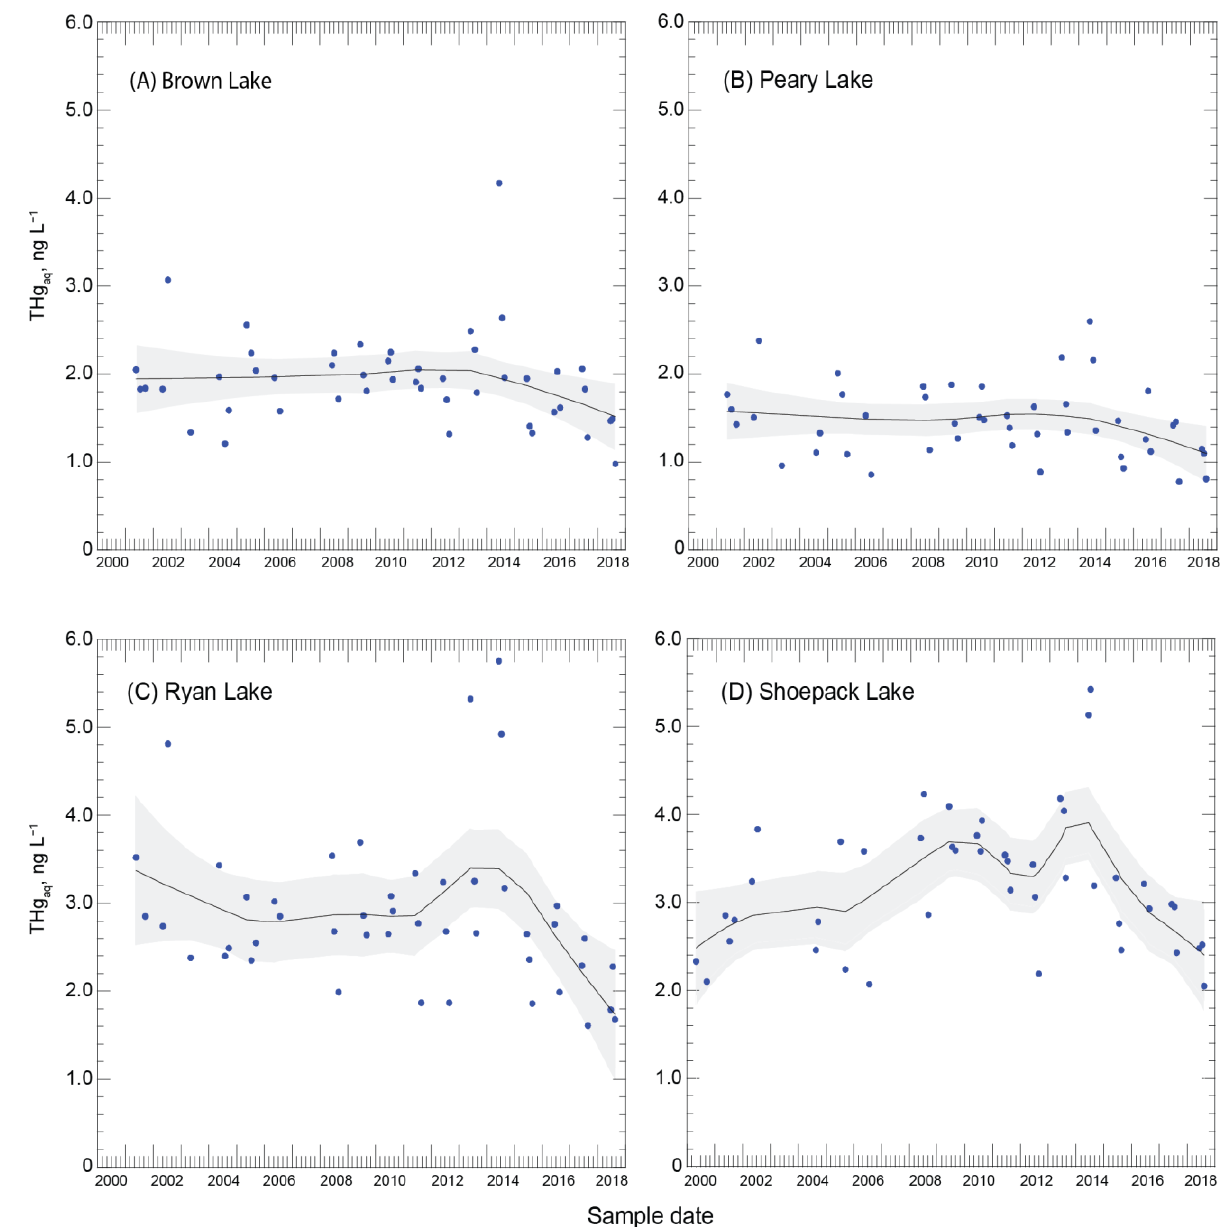
Figure 4. Time series plots for total mercury (THg aq ) in epilimnetic lake water. Smooth lines are locally weighted regression lines; smoothing parameters, selected as described in the methods section: ( A ) Brown Lake, smoothing parameter = 0.713; ( B ) Peary Lake, smoothing parameter = 0.641; ( C ) Ryan Lake, smoothing parameter = 0.424; ( D ) Shoepack Lake, smoothing parameter = 0.3. Gray shading indicates the 95-percent confidence interval.